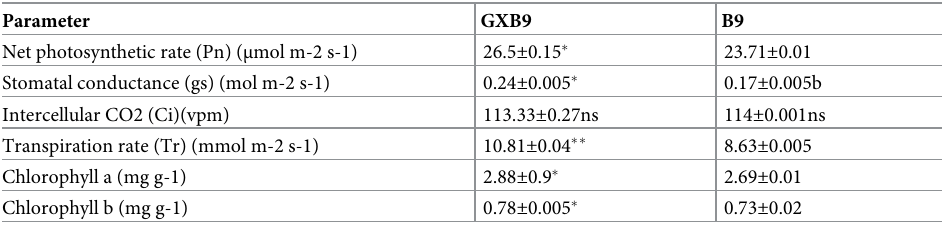
Table 5. Summary of photosynthetic components and chlorophyll evaluation.